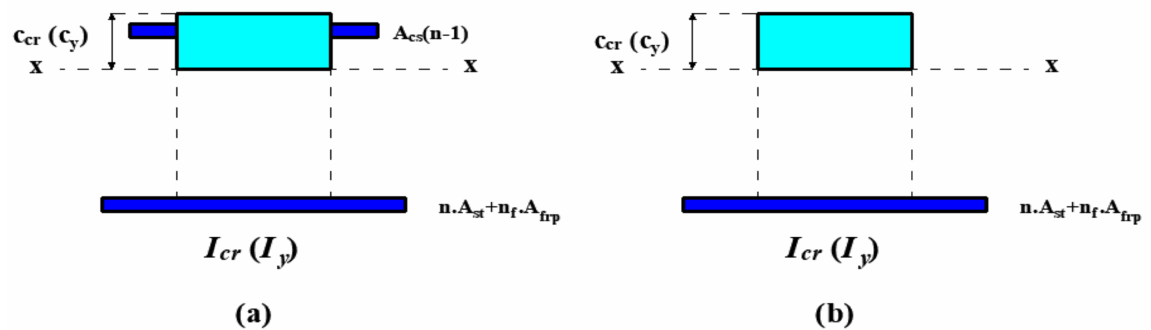
Figure 8. Equivalent transformed section at the fully cracked state and the initiation of tension steel yielding for beams ( a ) with and ( b ) without compression